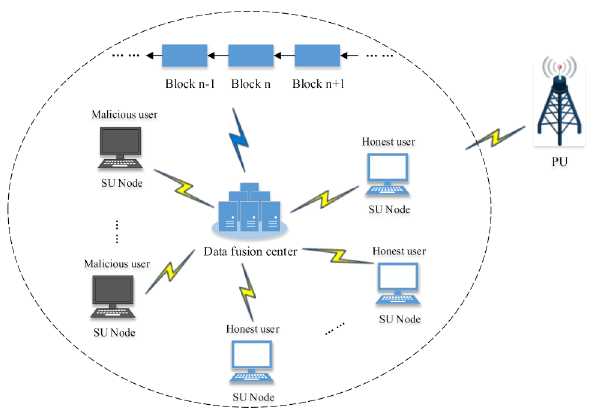
Figure 1. CSS system model with malicious